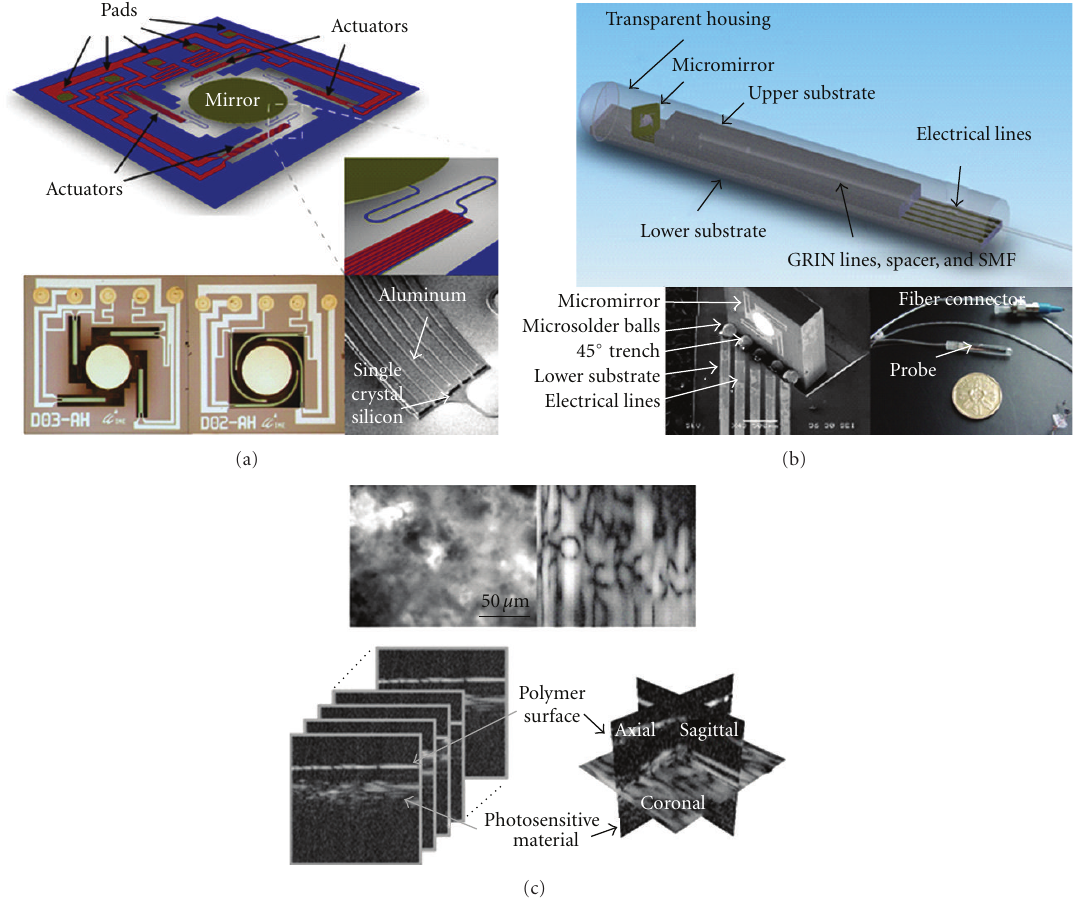
Figure 9: Electrothermal MEMS OCT reported by Xu et al. (a) two-axis electrothermal MEMS mirror, (b) probe design and assembly demonstration, and (c) 2D and 3D OCT image of an IR card. Reprint permission granted by IOP.